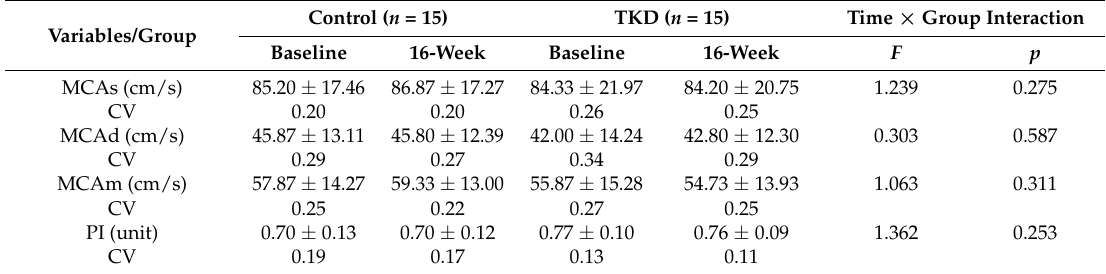
Table 5. Cerebral blood flow velocities in the control and TKD groups before and after the intervention. Control ( n = 15) TKD ( n = 15) Variables/Group